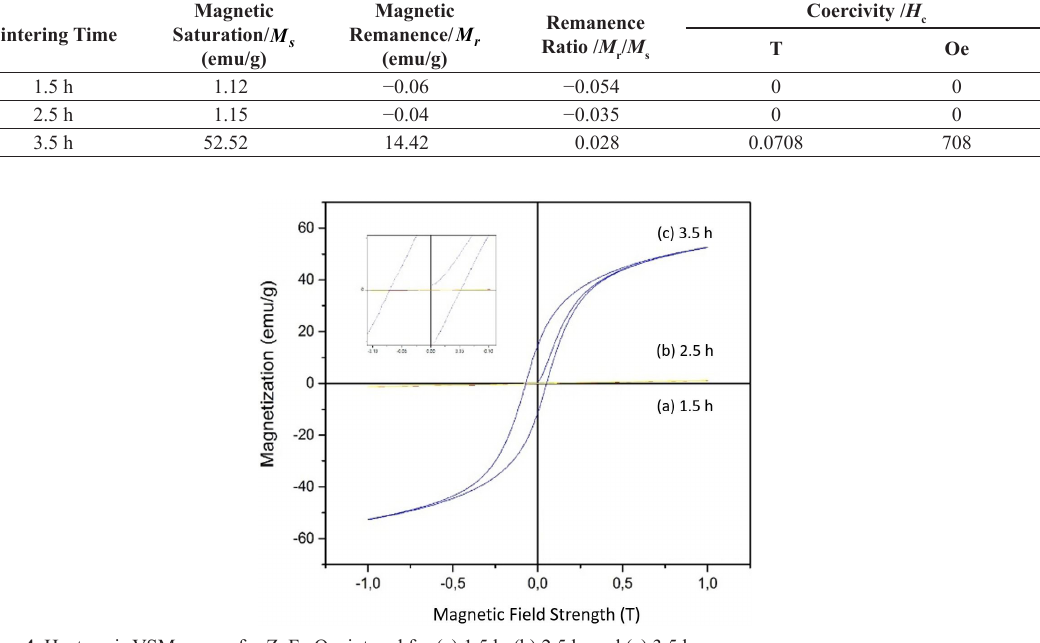
O sintered for (a) 1.5 h, (b) 2.5 h, and (c) 3.5 h. 2 4